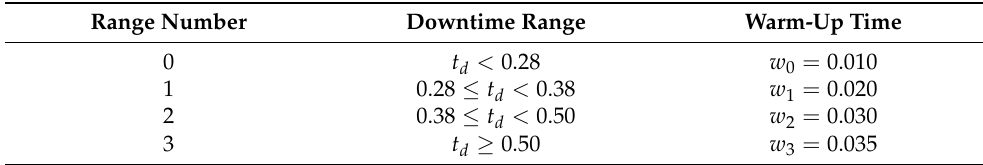
Table 4. Warm-up time diagram based on the downtime range. Range Number